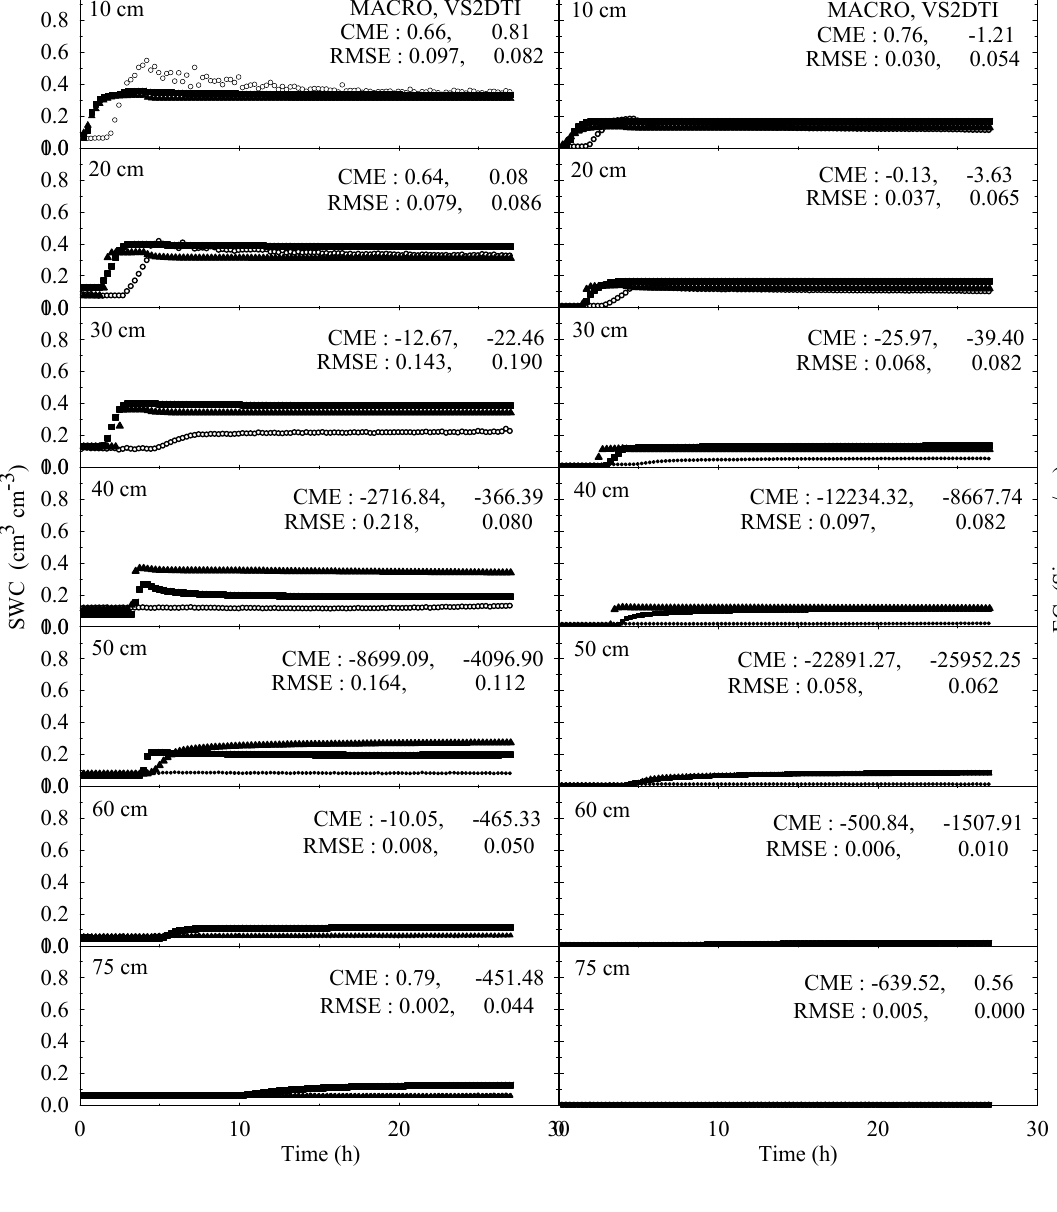
RMSE : 0.097, 0.082